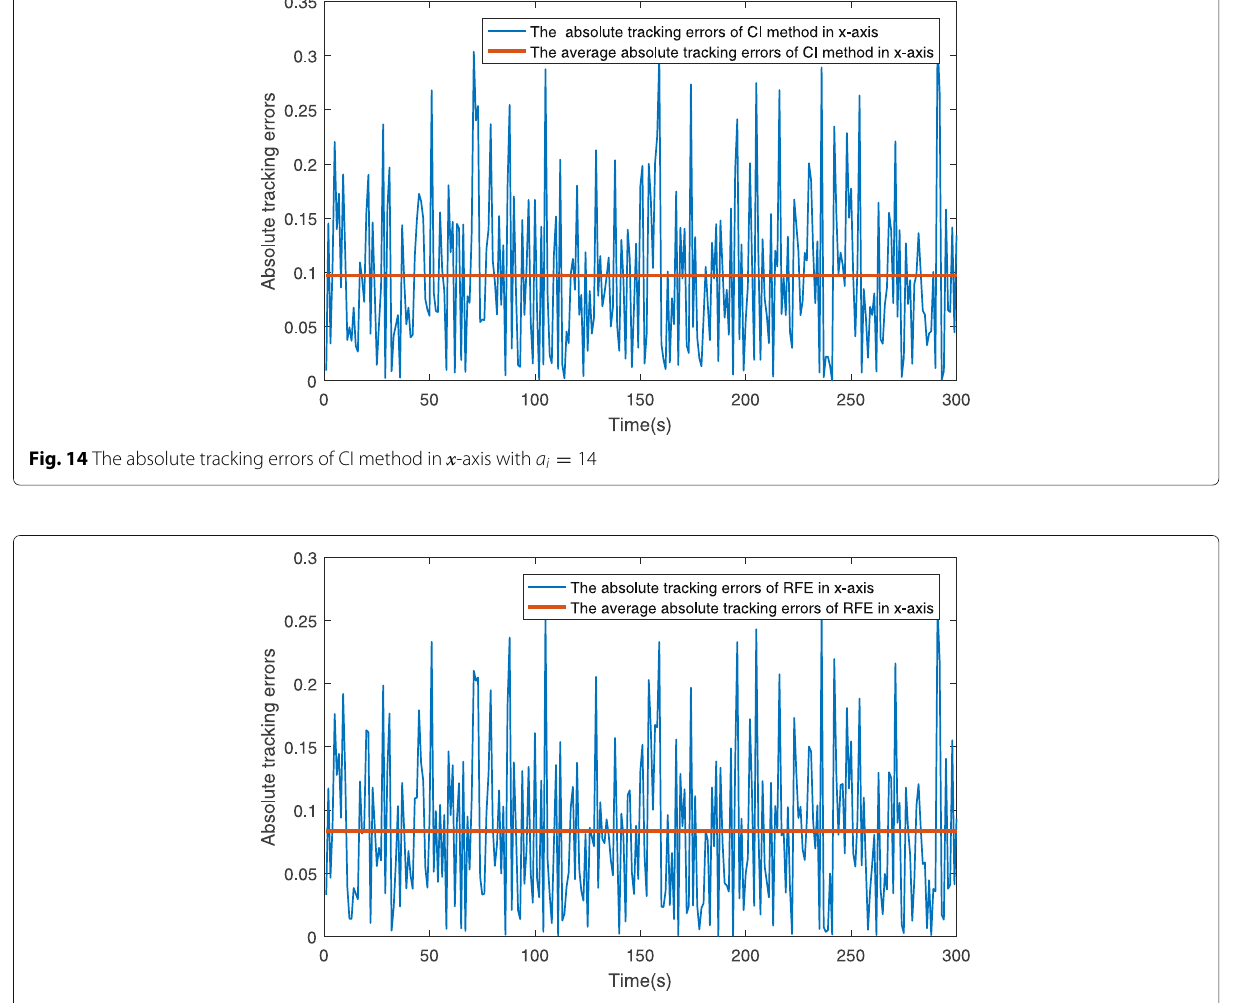
Fig. 15 The absolute tracking errors of RFE in x -axis with a i =